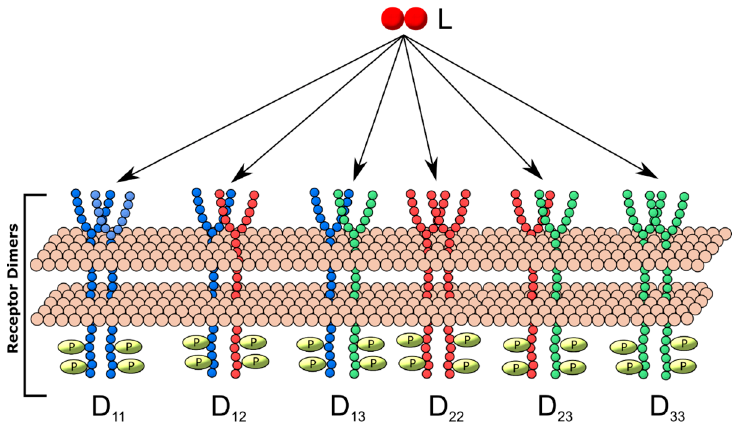
Figure 3. Three receptor, one-ligand (3R1L) dimerization model schematic. Three receptor monomers, R 1 (blue), R 2 (red) and R 3 (green), bind ligand L and form dimers D ij , where i and j represent receptor monomers. Thus, D 11 is a homodimer containing two R 1 , D 12 is a heterodimer containing one R 1 , etc.